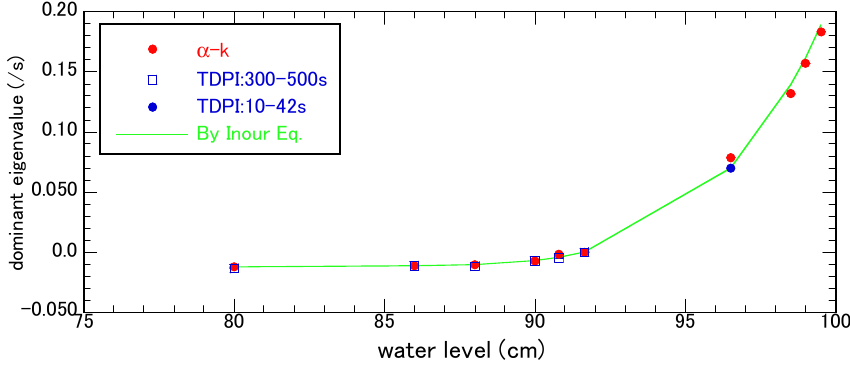
Figure 3. Comparison of α eigenvalue between α - k , TDPI, and the inhour